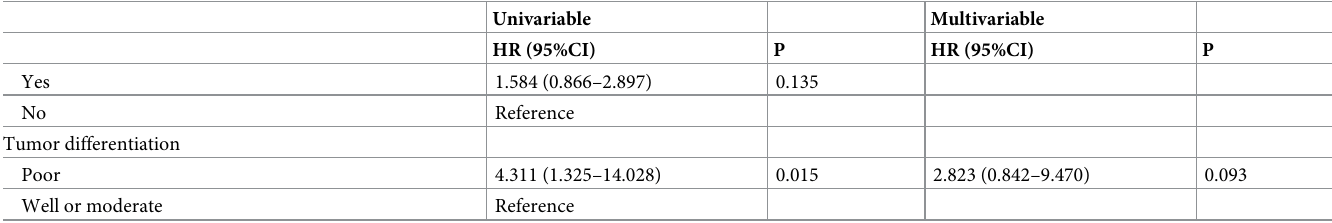
S2 Fig. Overall survival rates of cirrhotic patients with solitary hepatocellular carcinoma according to presence of microvascular invasion (MVI). S3 Fig. Recurrent-free survival rates of cirrhotic patients with solitary hepatocellular carci- noma according to presence of microvascular invasion (MVI). S4 Fig. Overall survival rates of non-cirrhotic patients with solitary hepatocellular carci- noma according to presence of microvascular invasion (MVI). S5 Fig. Recurrent-free survival rates of non-cirrhotic patients with solitary hepatocellular carcinoma according to presence of microvascular invasion